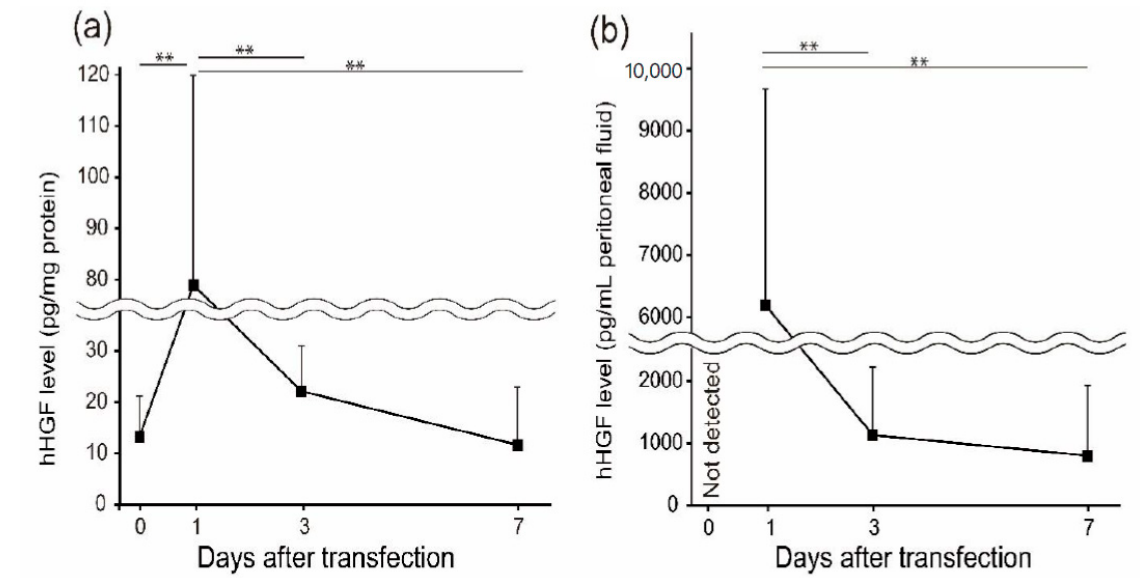
Figure 1. Human hepatocyte growth factor (hHGF) expression periods of chlorhexidine digluconate (CG)-induced peritoneal fibrosis by sonoporation-mediated hHGF transfection. Following hHGF transfection, CG was injected every day. The hHGF expression level in the peritoneal wall ( a ) and peritoneal fluid ( b ) was analyzed on days 1, 3, and 7 after transfection. Values are expressed as the mean + SD ( n = 5). ** p < 0.01 by Tukey’s multiple comparison test.